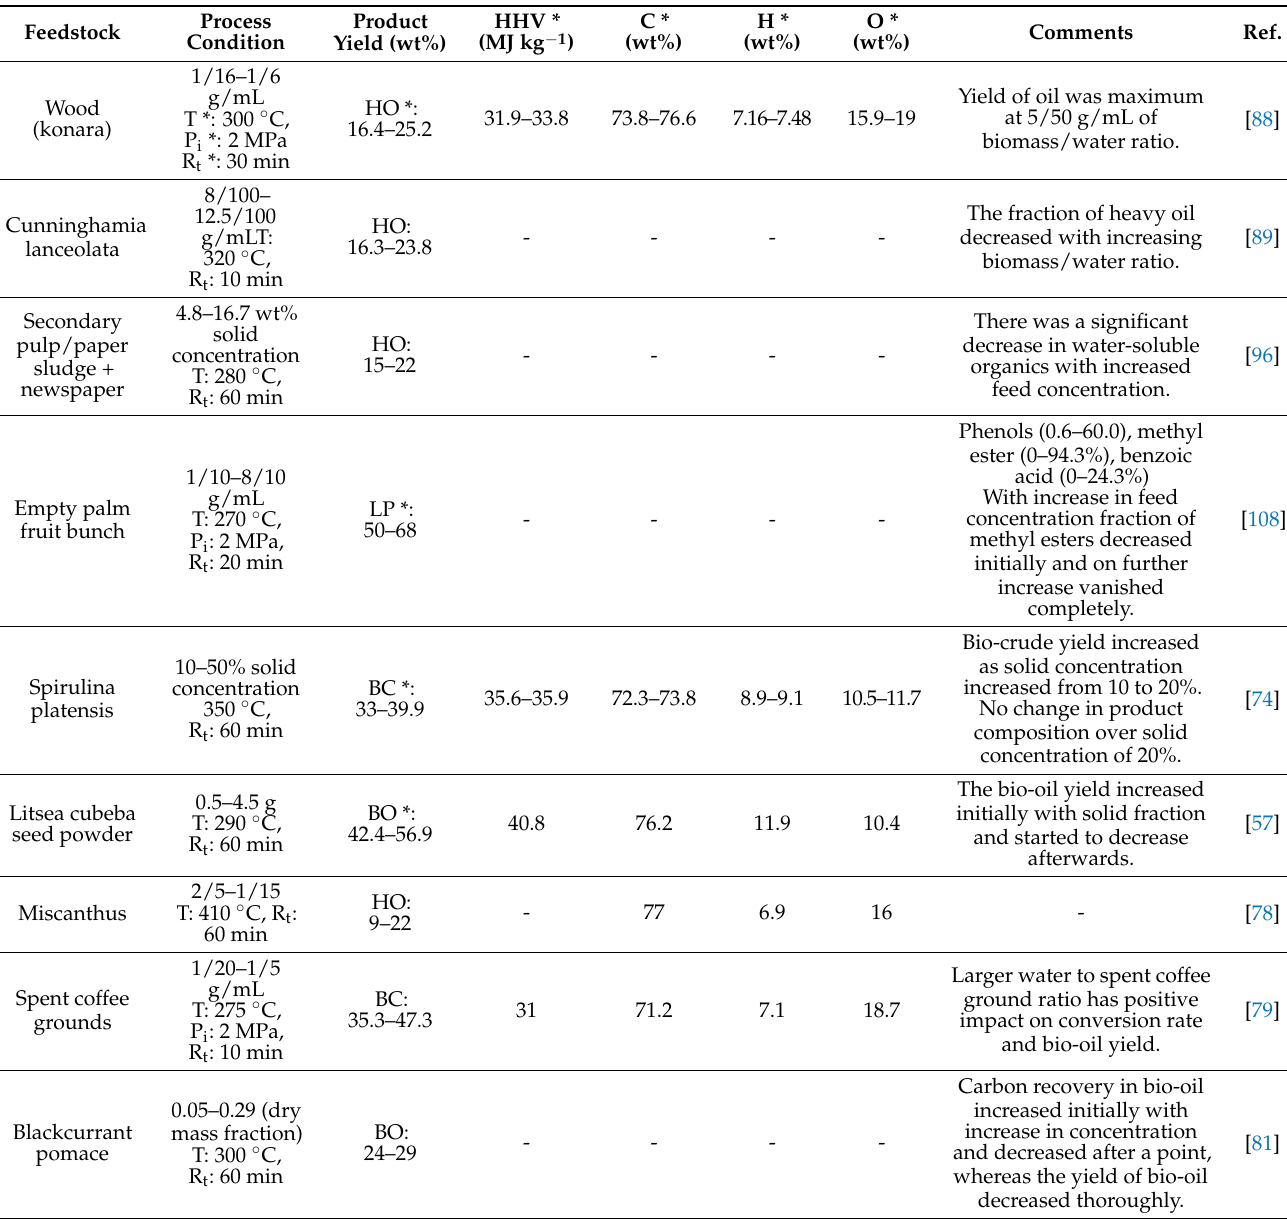
Table 7. Effect of the feed ratio in HTL process.